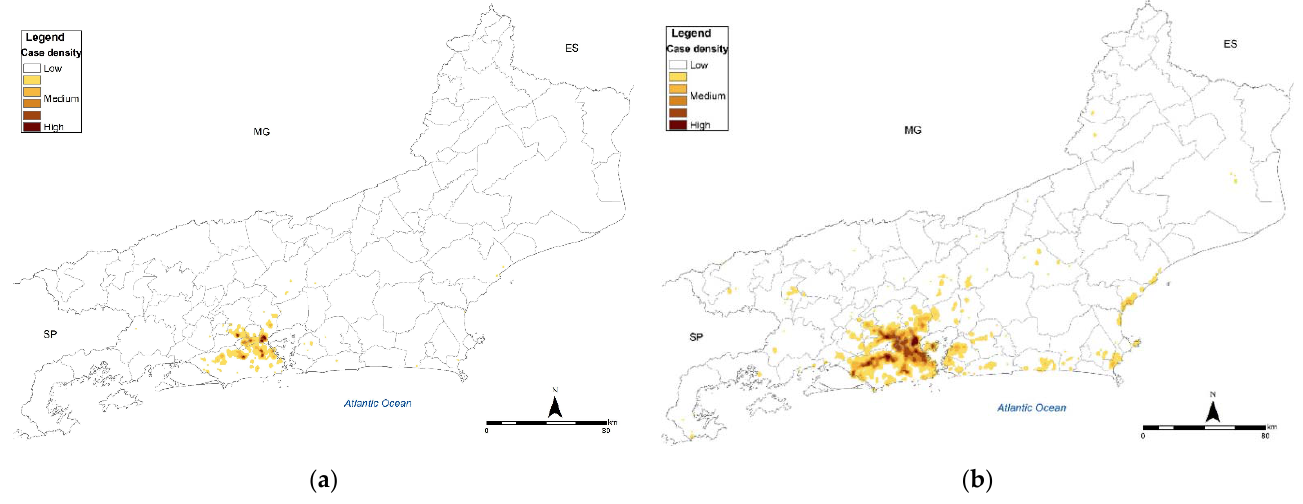
Figure 2. Spatial distribution (Kernel map) of sporotrichosis cases in the state of Rio de Janeiro ( a ) 2008; ( b ) accumulated from 2008 to 2015 (Source: SES-RJ, Sipec. Limits of neighborhoods: Demographic Census 2010, IBGE. Map created by the authors).